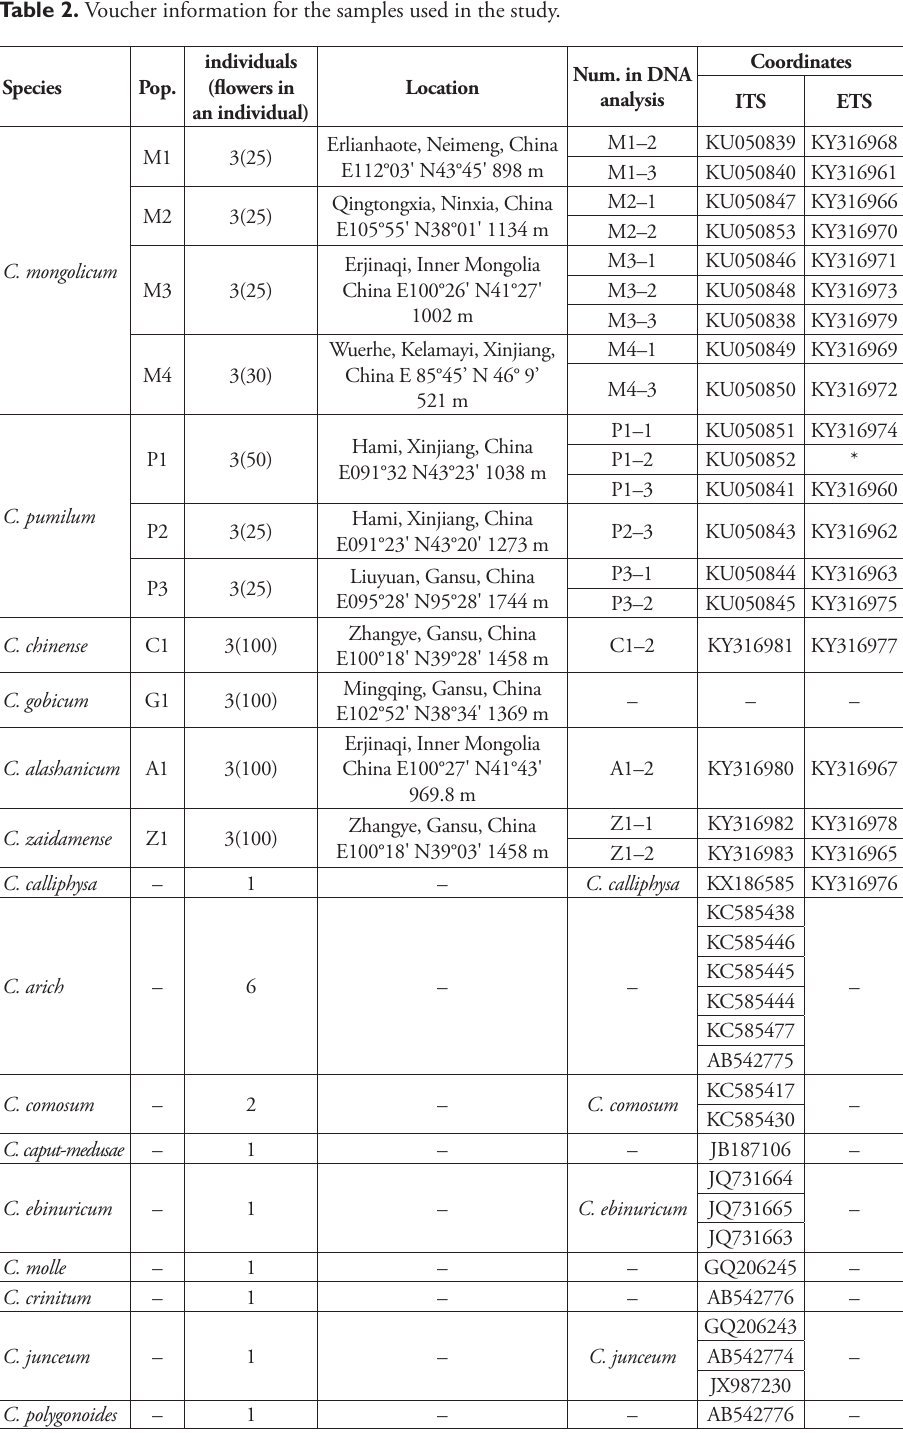
Table 2. Voucher information for the samples used in the study. Species Pop.